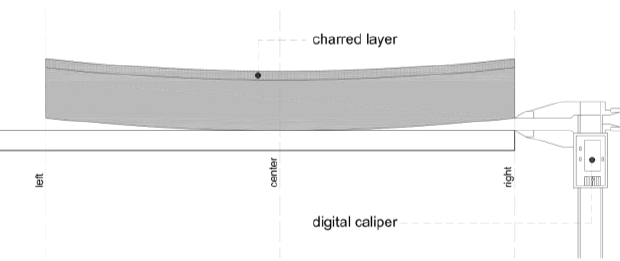
Figure 3. Cupping effect measurements of one-sided surface charred wood sample.